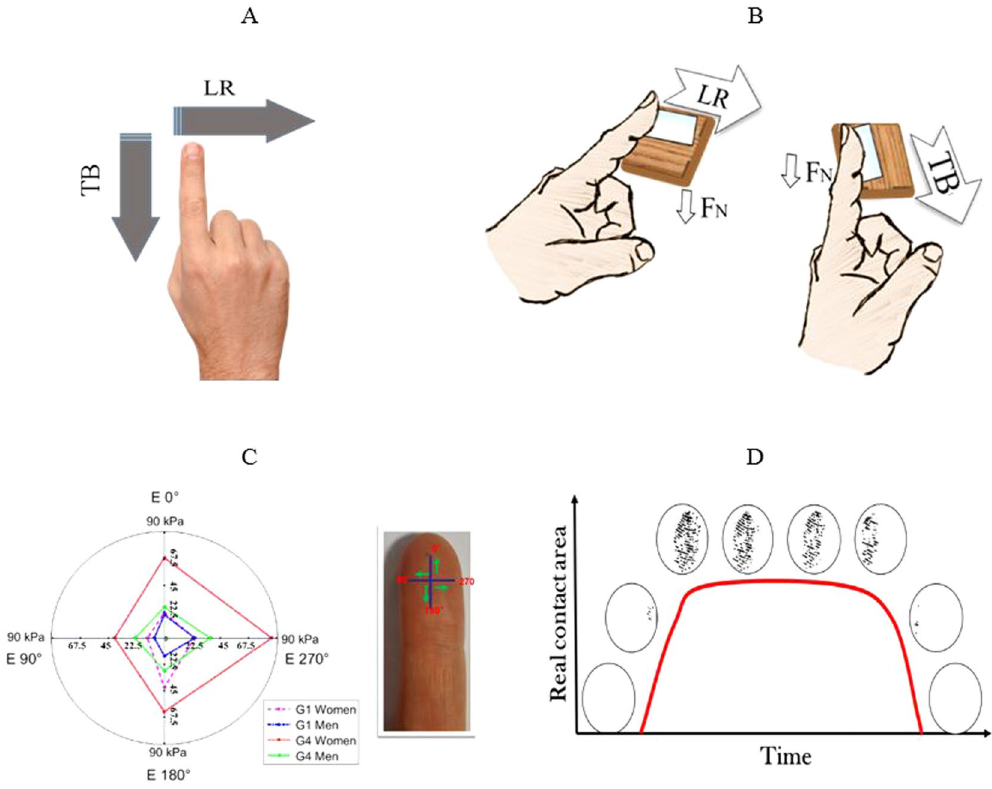
Figure 4. ( A,B ) The two defined directions (left to right (LR) and top to bottom (TB)) 37 . 5 uniform forward translations in the two directions, normal force: 0.3–0.4 N, sliding speed: 20–30 mm.s − 1 , friction length: 10 mm. The movement is generated by the whole arm. ( C ) Illustration of the anisotropy of the finger’s mechanical properties for both men and women of the youngest and the older groups 37 . The two age groups (G1, G4) correspond to (26 ± 3 and 58 ± 6 years old), respectively, for men and women (this illustration is taken from our previous study) 37 . The evolution of Young’s modulus with age is anisotropic as a function of the direction measured. The results demonstrate a higher E for the exterior part of the finger skin (0°, 270°). The exterior part of the finger is more exposed to the environment and to repeated friction in daily life (i.e., writing); therefore, increasing anisotropy of mechanical properties with age can be observed 37 . ( D ) Illustration of the evolution of the real contact area as a function of time during the touch